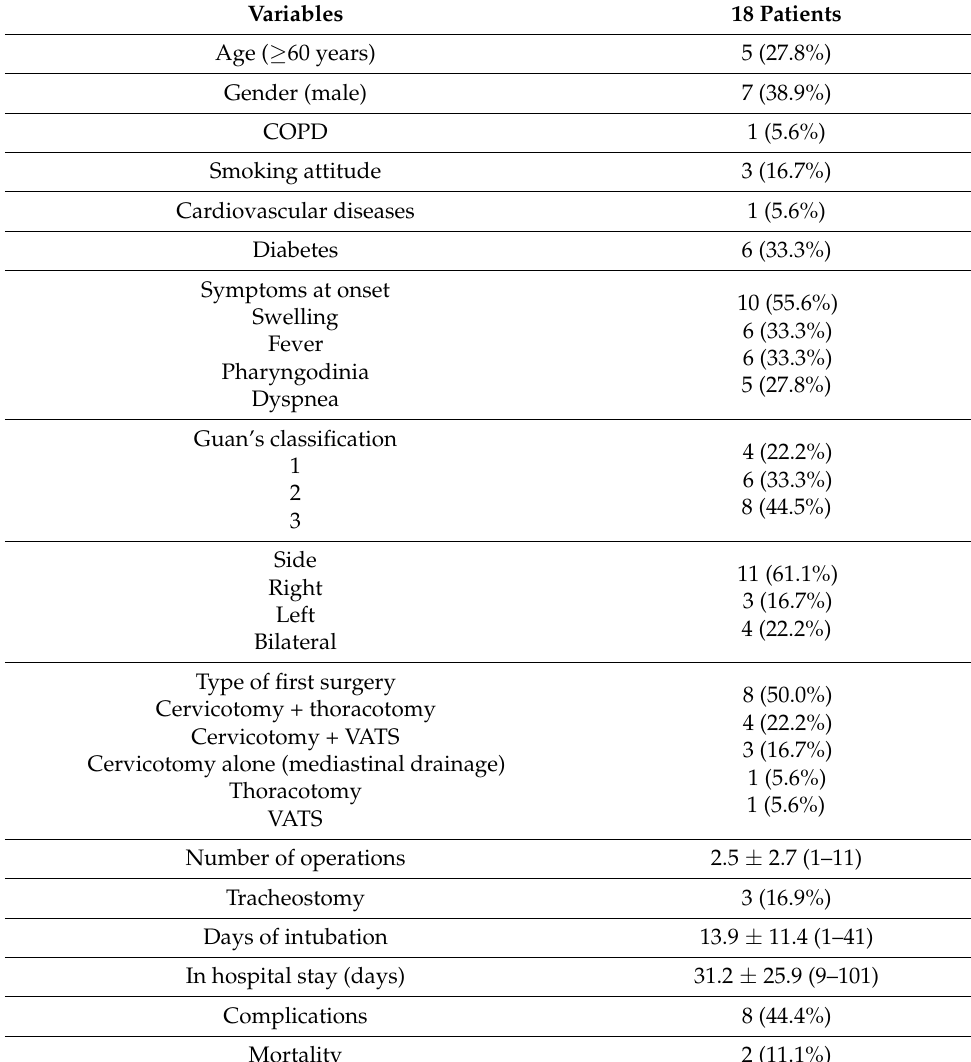
Table 1. Clinical-pathological characteristics of the